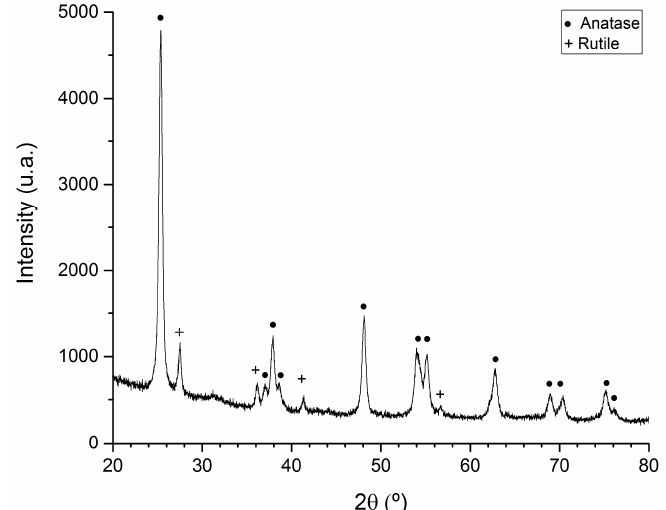
Figure 2. XRD diffractogram of the TiO 2 NPs used for the fabrication of the sol-gel coatings, which are composed of a mixture of rutile and anatase forms.